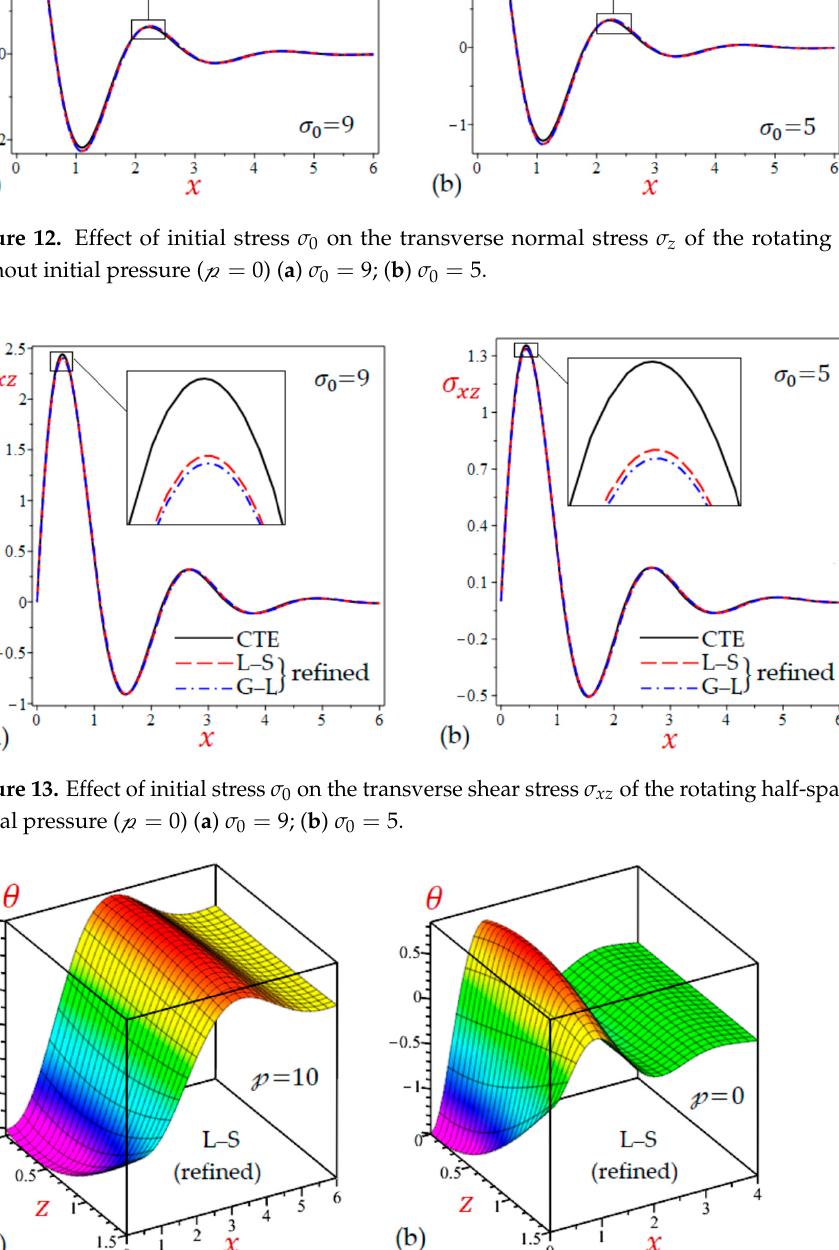
Figure 14. 3D distributions of the temperature θ of the rotating half-space: ( a ) with initial pressure